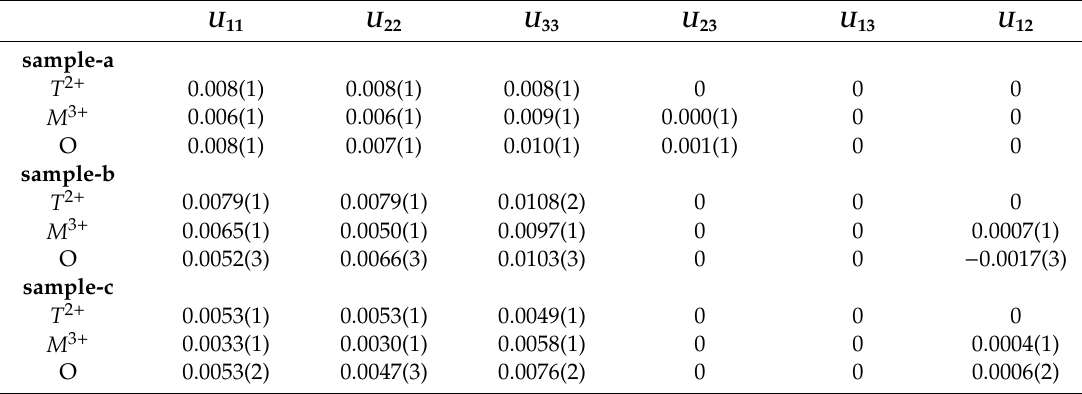
Table 6. Anisotropic † displacement parameters (Å 2 ) for three hausmannite samples.